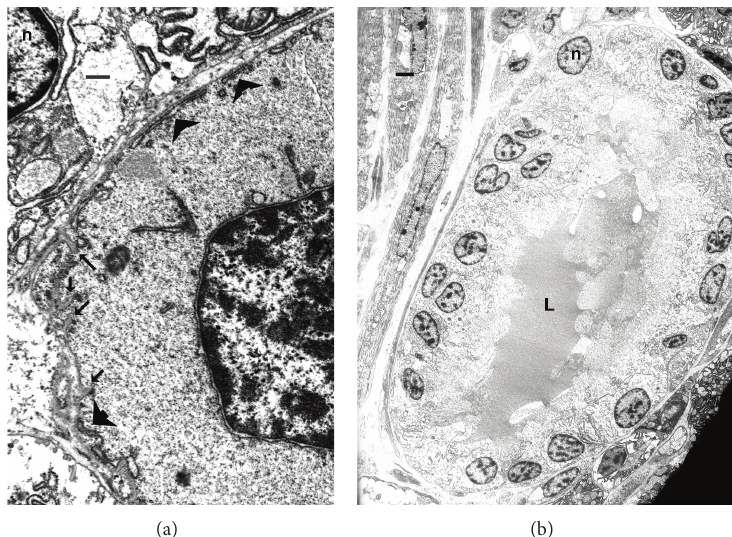
Figure 3: Vesicle cell and duct from amber vesicle of Aplysia californica . (a) Enlarged portion of vesicle cell from Figure 2(f) with sack-like invaginations (arrows) of the cell membrane which is also closely associated with rough endoplasmic reticulum cisternae (arrow heads). (b) Duct lumen filled with protein. L, lumen; n, nucleus. Scale bars: (a) = 0.5 𝜇 m; (b) = 2 𝜇